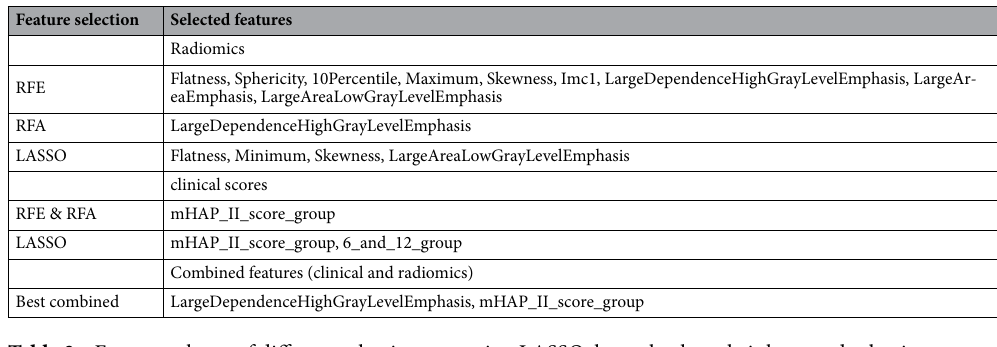
Table 2. Feature subsets of different selection strategies. LASSO, least absolute shrinkage and selection operator; RFA, recursive feature addition; RFE, recursive feature elimination. See Supplementary Data S8 for more